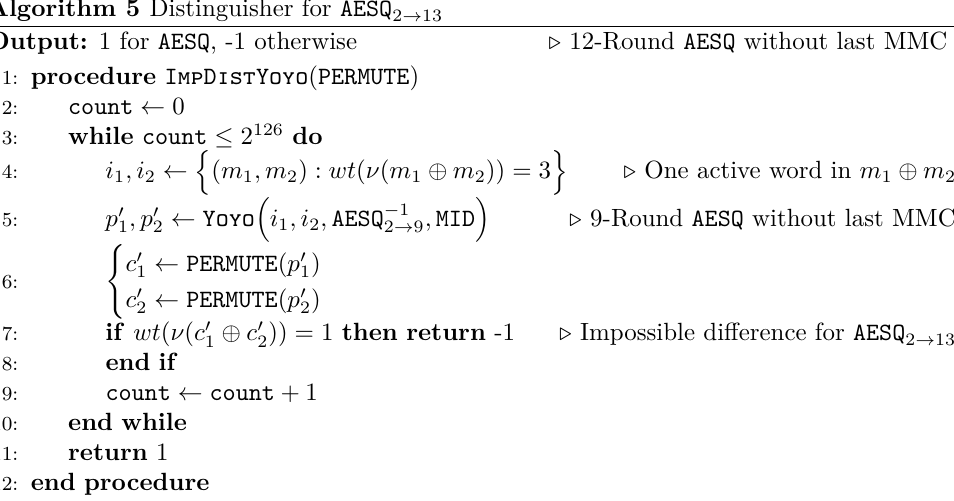
Algorithm 5 Distinguisher for AESQ